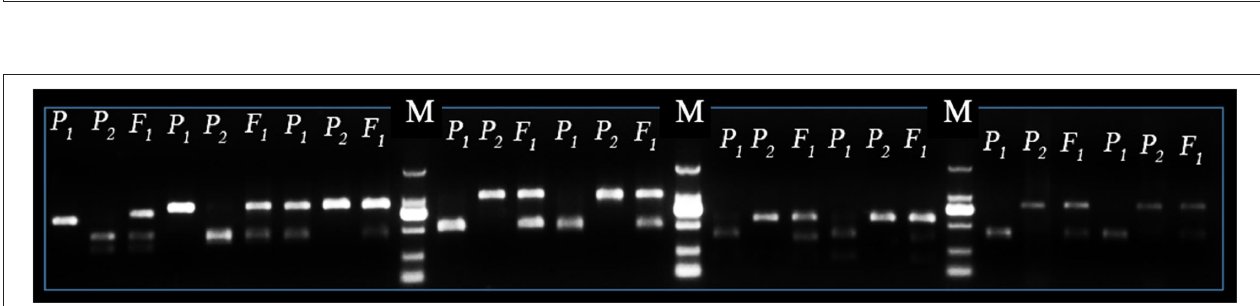
FIGURE 4 | Identification of SNP-CAPS markers polymorphism between female parent (LSW-177 as P 1 ), male parent (ZXG-1555 as P 2 ), and their F 1 progeny. The letter “M” is the marker (DL2000) ladder, respectively.